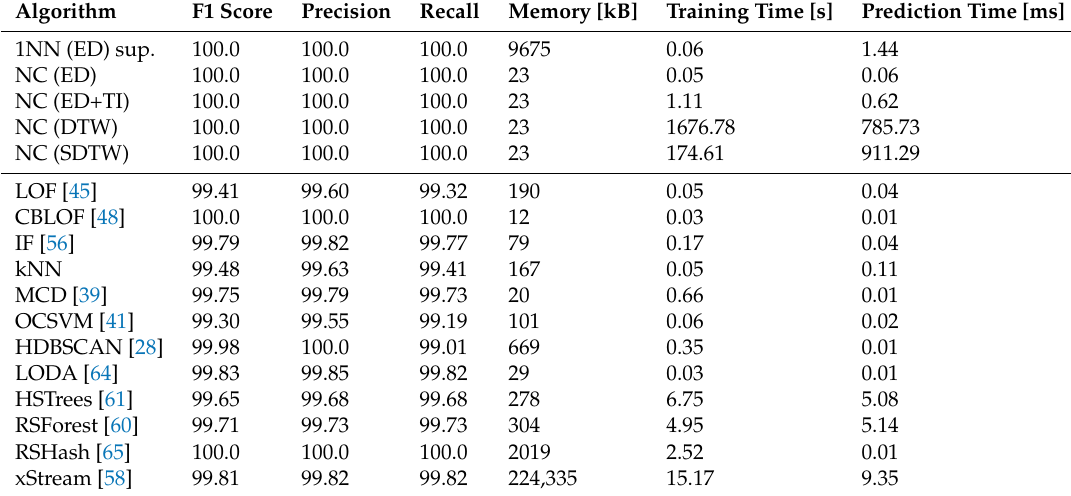
Table 2. Comparison of anomaly detection models on data set DS2 (binary